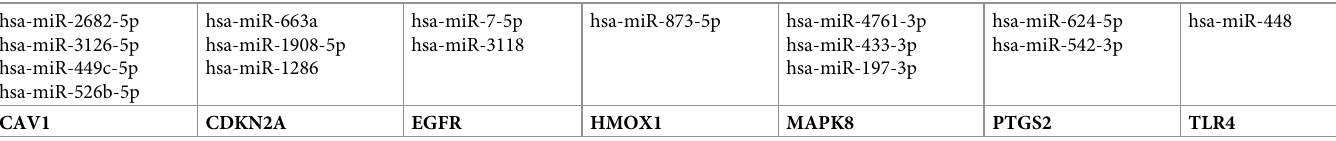
Table 3. Key miRNAs that regulate hub genes predicted by six